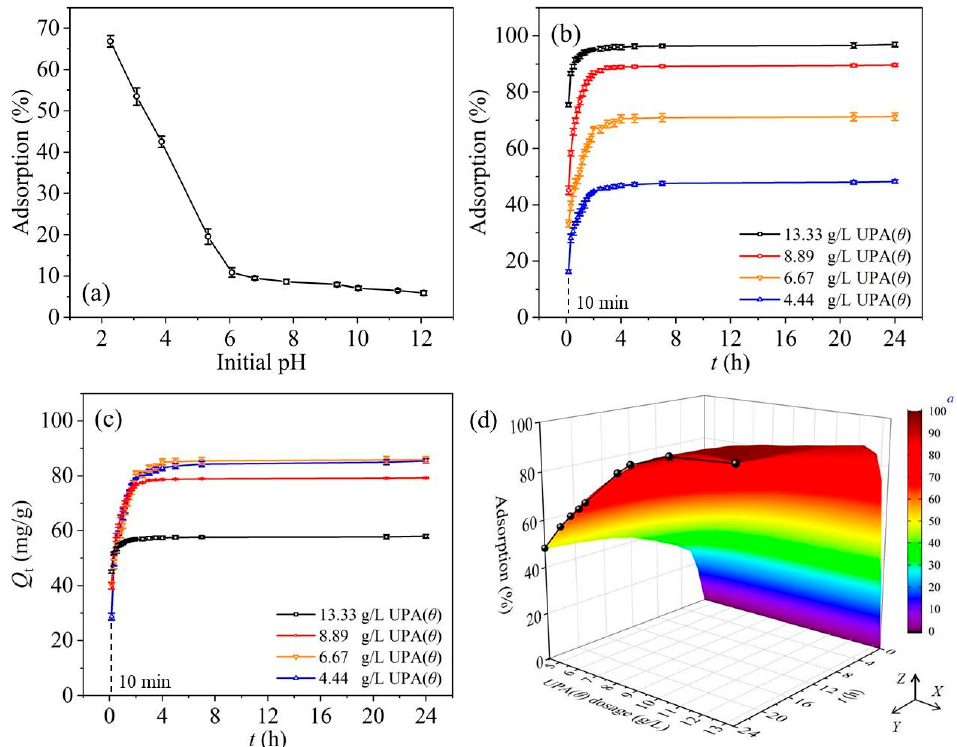
Figure 3. ( a ) Effect of initial pH on RBBR adsorption, C [RBBR]initial = 800 mg·L − 1 , m/V [UPA( θ )] = 4.44 g·L − 1 , I = 100 mmol·L − 1 sodium acetate, T = 310 K, stirring speed = 150 rpm, and equilibrium time = 24 h. Adsorption kinetics regarding the ( b ) adsorption percentage and ( c ) adsorption capacity of RBBR retained by UPA( θ ) powders; ( d ) effect of UPA( θ ) dosage on RBBR adsorption kinetics. C [RBBR]initial = 800 mg·L − 1 , initial pH = 4.0 ± 0.1, I = 100 mmol·L − 1 sodium acetate, T = 310 K, stirring speed = 150 rpm, and terminal equilibrium time = 24 h. a Three-dimensional curved surface simulation based on MATLAB matrix conversion and gridding.